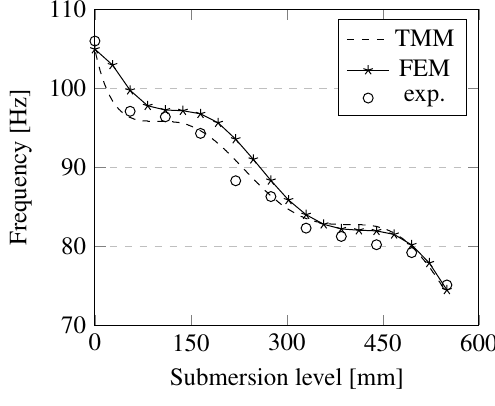
Fig. 6. First natural frequency during immersion